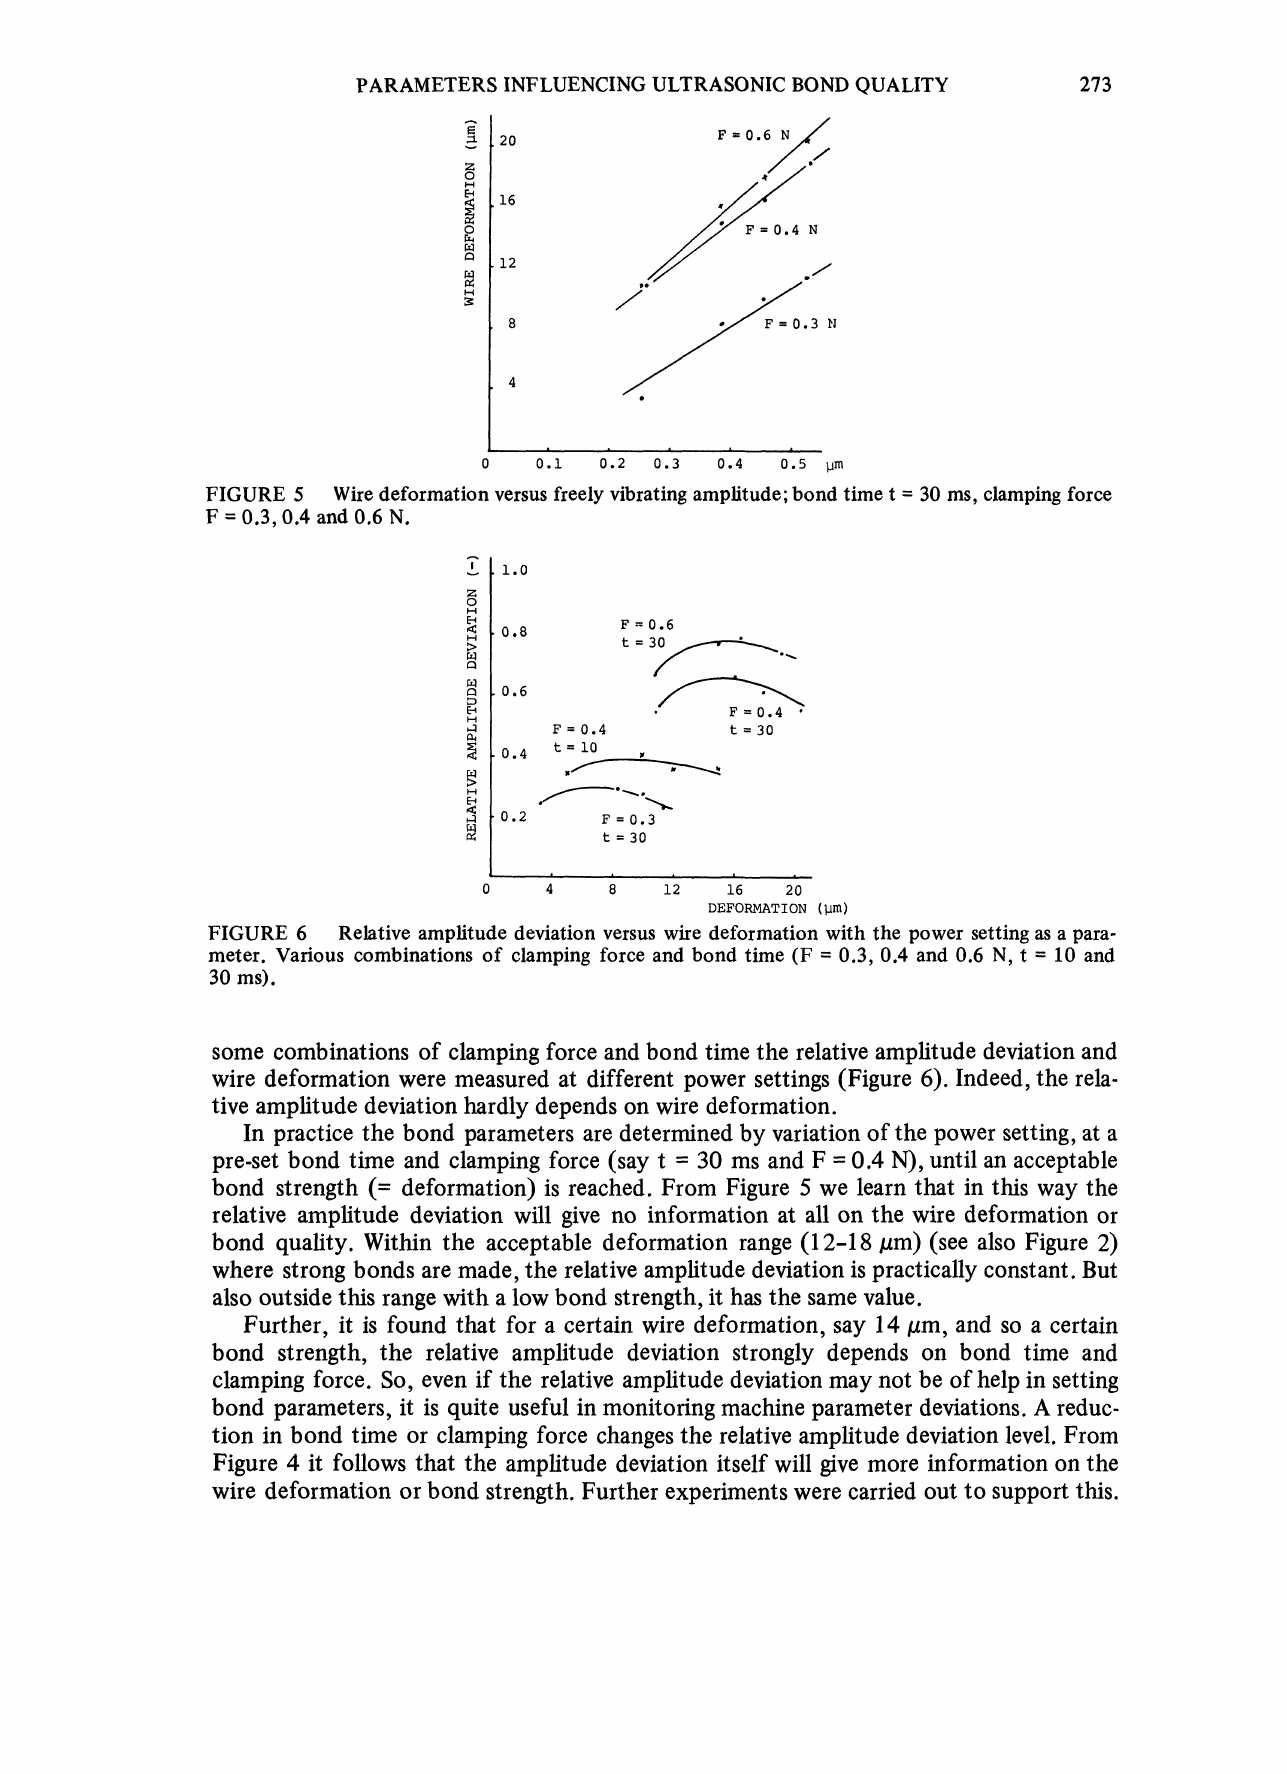
Wire deformation versus freely vibrating amplitude; bond time 30 ms, clamping force F 0.3, 0.4 and 0.6 N.